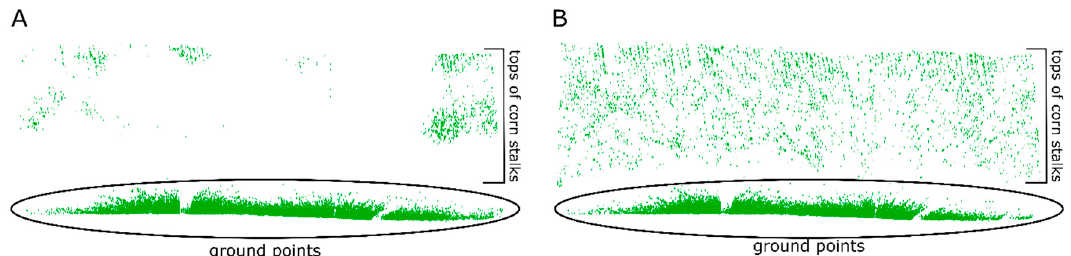
Figure 6. Ground points classified using the HWRI ( A ), CSF ( B ), and MSBF ( C ) classifiers for the vegetated site demonstrating the misclassification of points along steep slopes (as seen from above at an oblique angle).